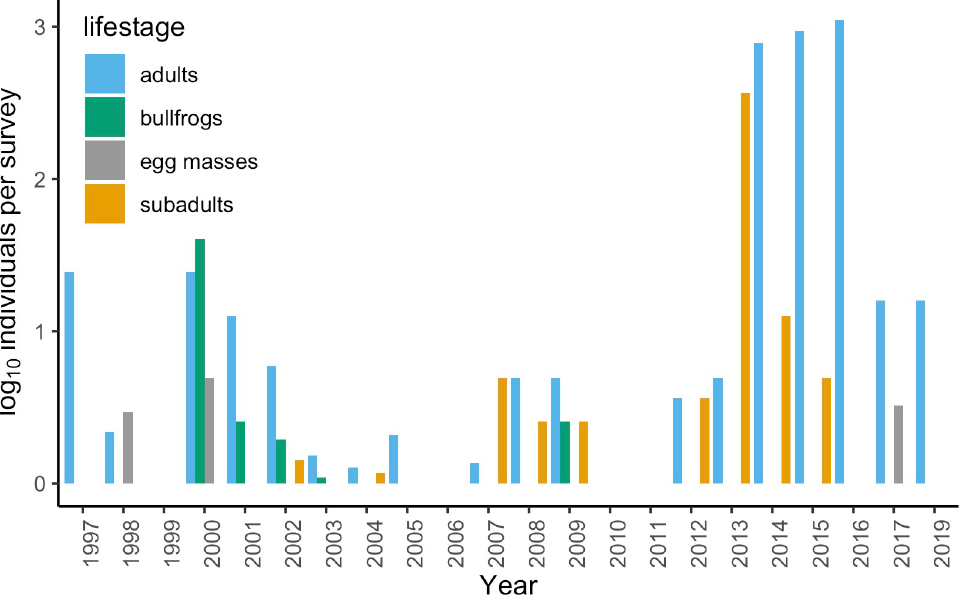
Fig 4. Twenty-two-year monitoring data for Spivey Pond collected and curated by the U.S. Bureau of Land Management. Lifestages are for California red-legged frogs ( Rana draytonii ); bullfrogs are non-native American bullfrogs ( Rana catesbeiana